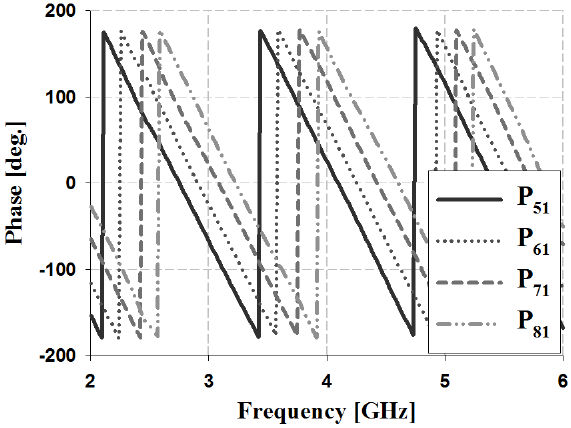
Figure 18. Measurement analysis of phase for input Port 1.